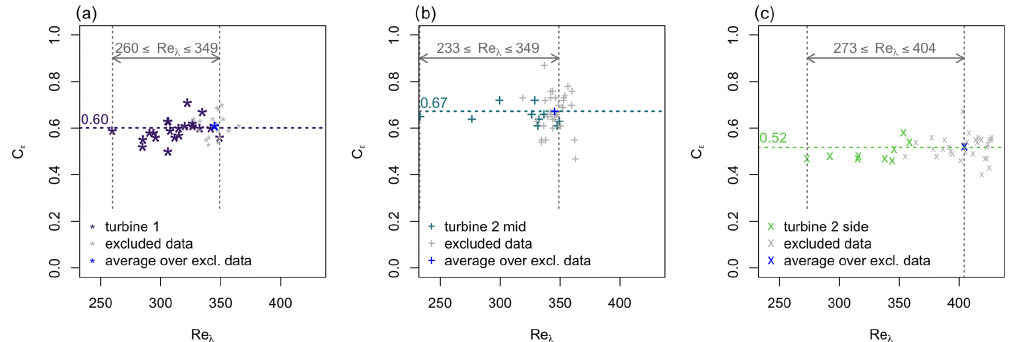
Figure 8. C ε ( Re λ ) at the centerline for the three different inflow conditions: (a) turbine 1 – laminar inflow, (b) turbine 2 mid – turbulent, and (c) turbine 2 side – turbulent and intermittent. In grey, data points within the downstream region where Re λ does not change are masked, and their mean value is plotted in blue.